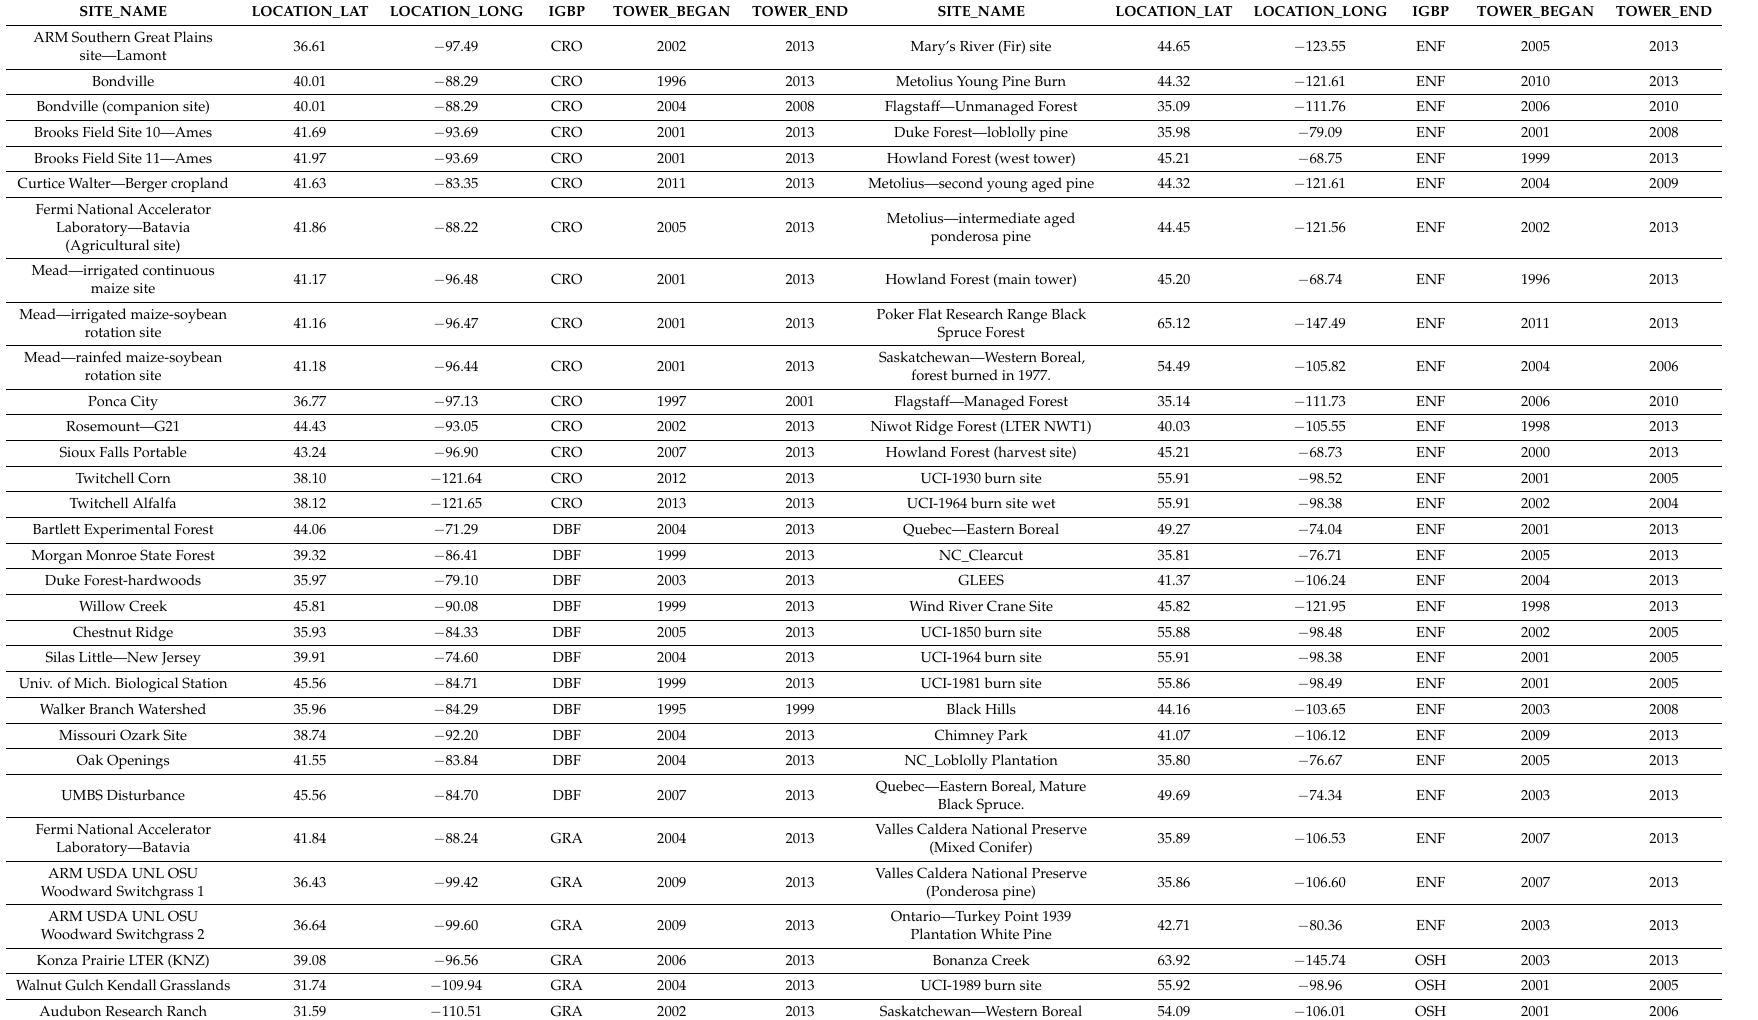
Table 1. Flux sites used in the